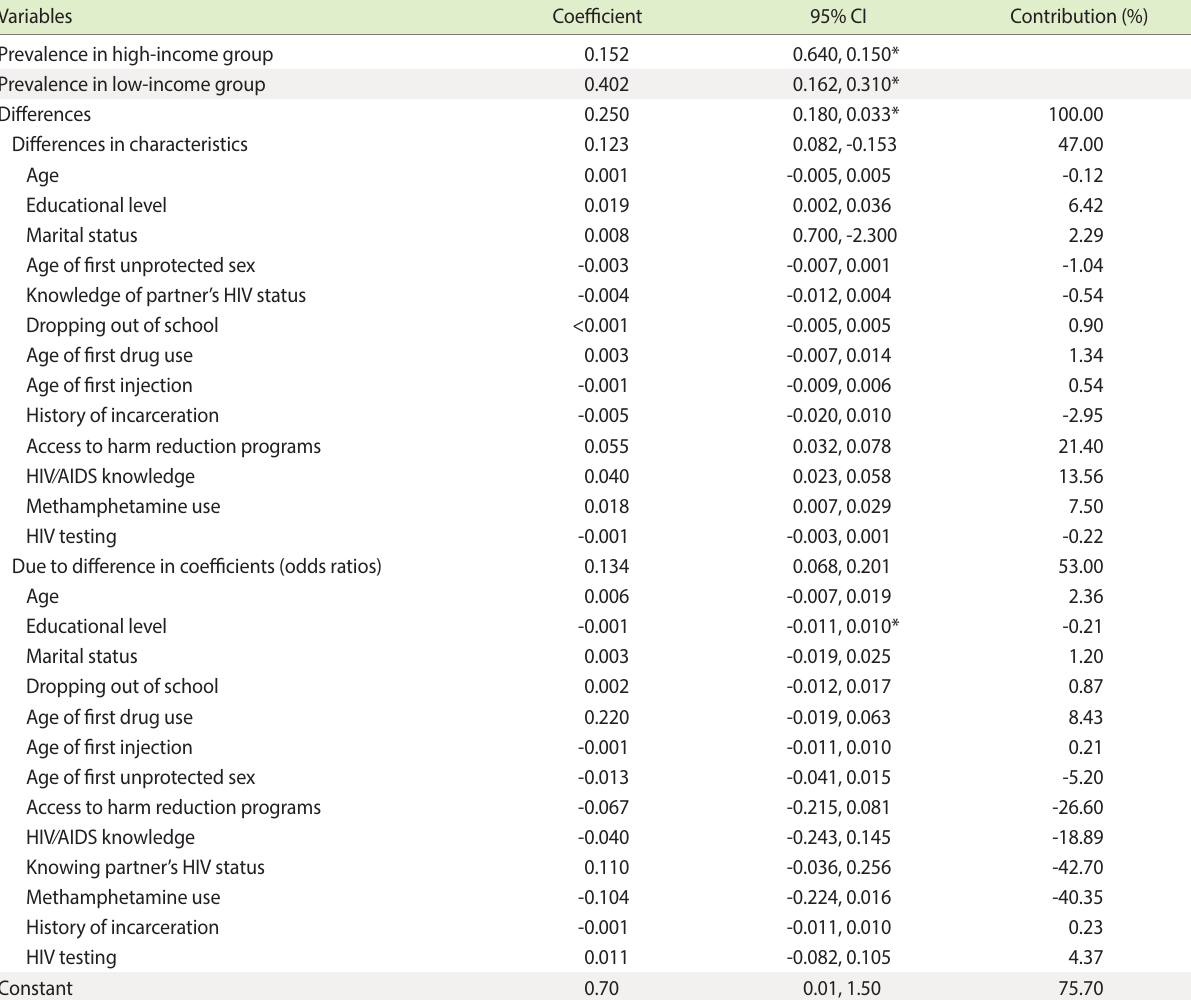
Table 3. Decomposition analysis of the contribution of socio-demographic factors to economic inequalities in unprotected sex